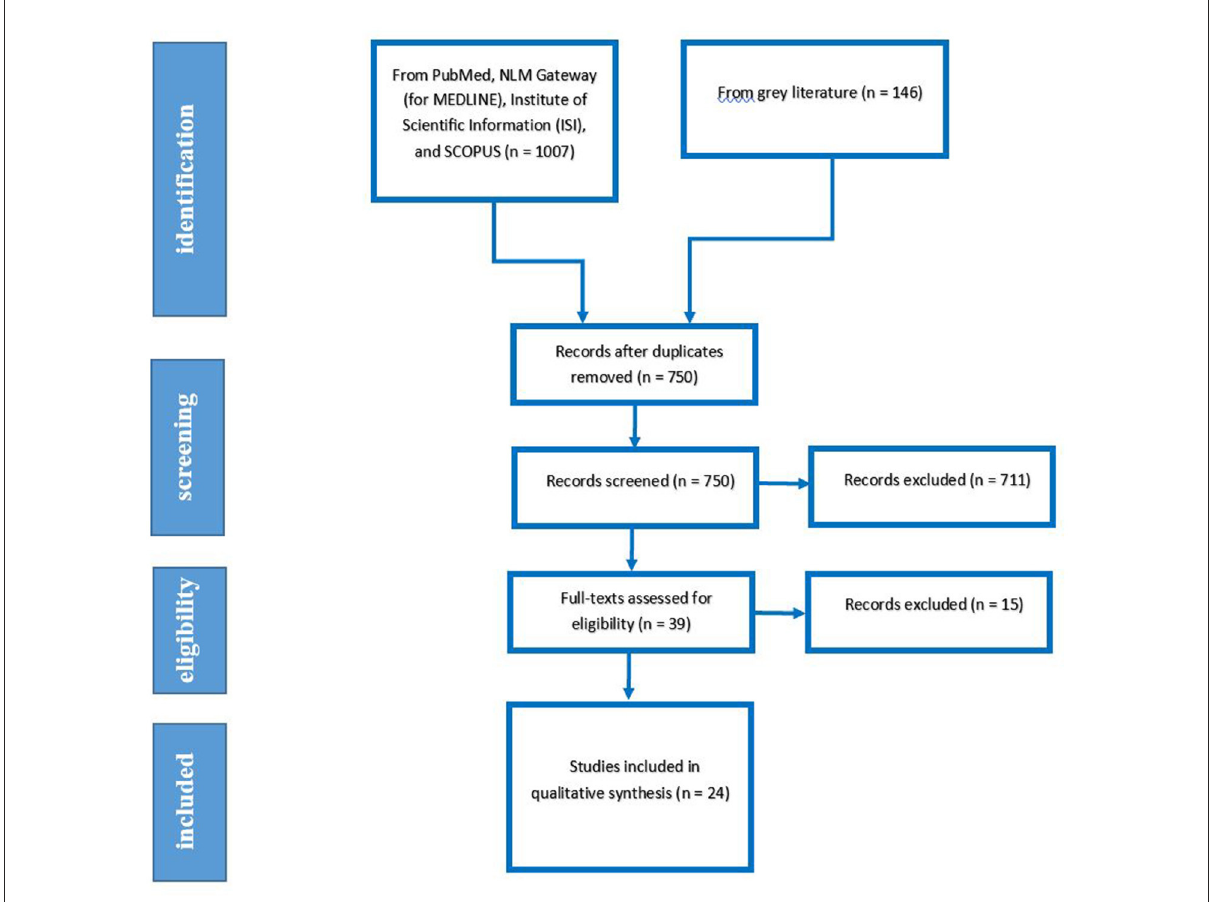
FIGURE1 PRISMA flow diagram for study